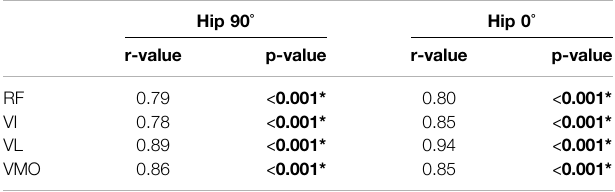
TABLE 2 | Contraction intensity comparisons.